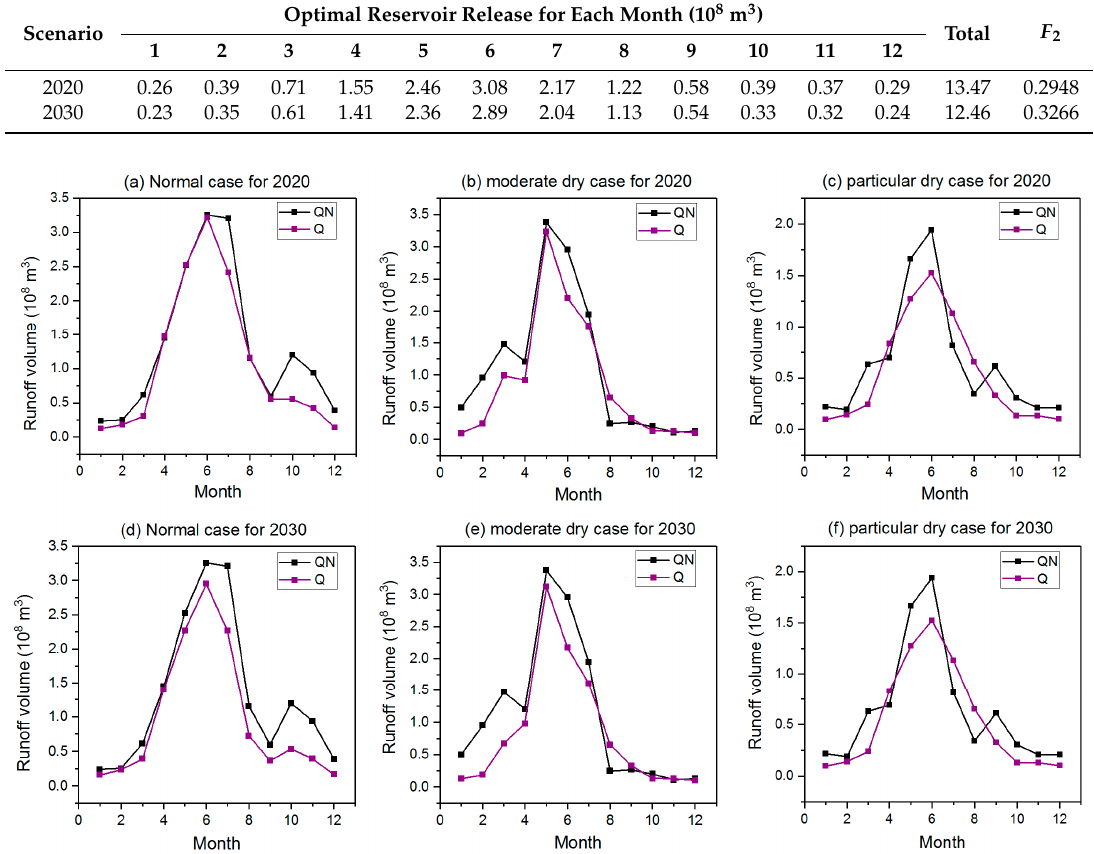
Figure 6. The annual distribution of natural flow and actual release.